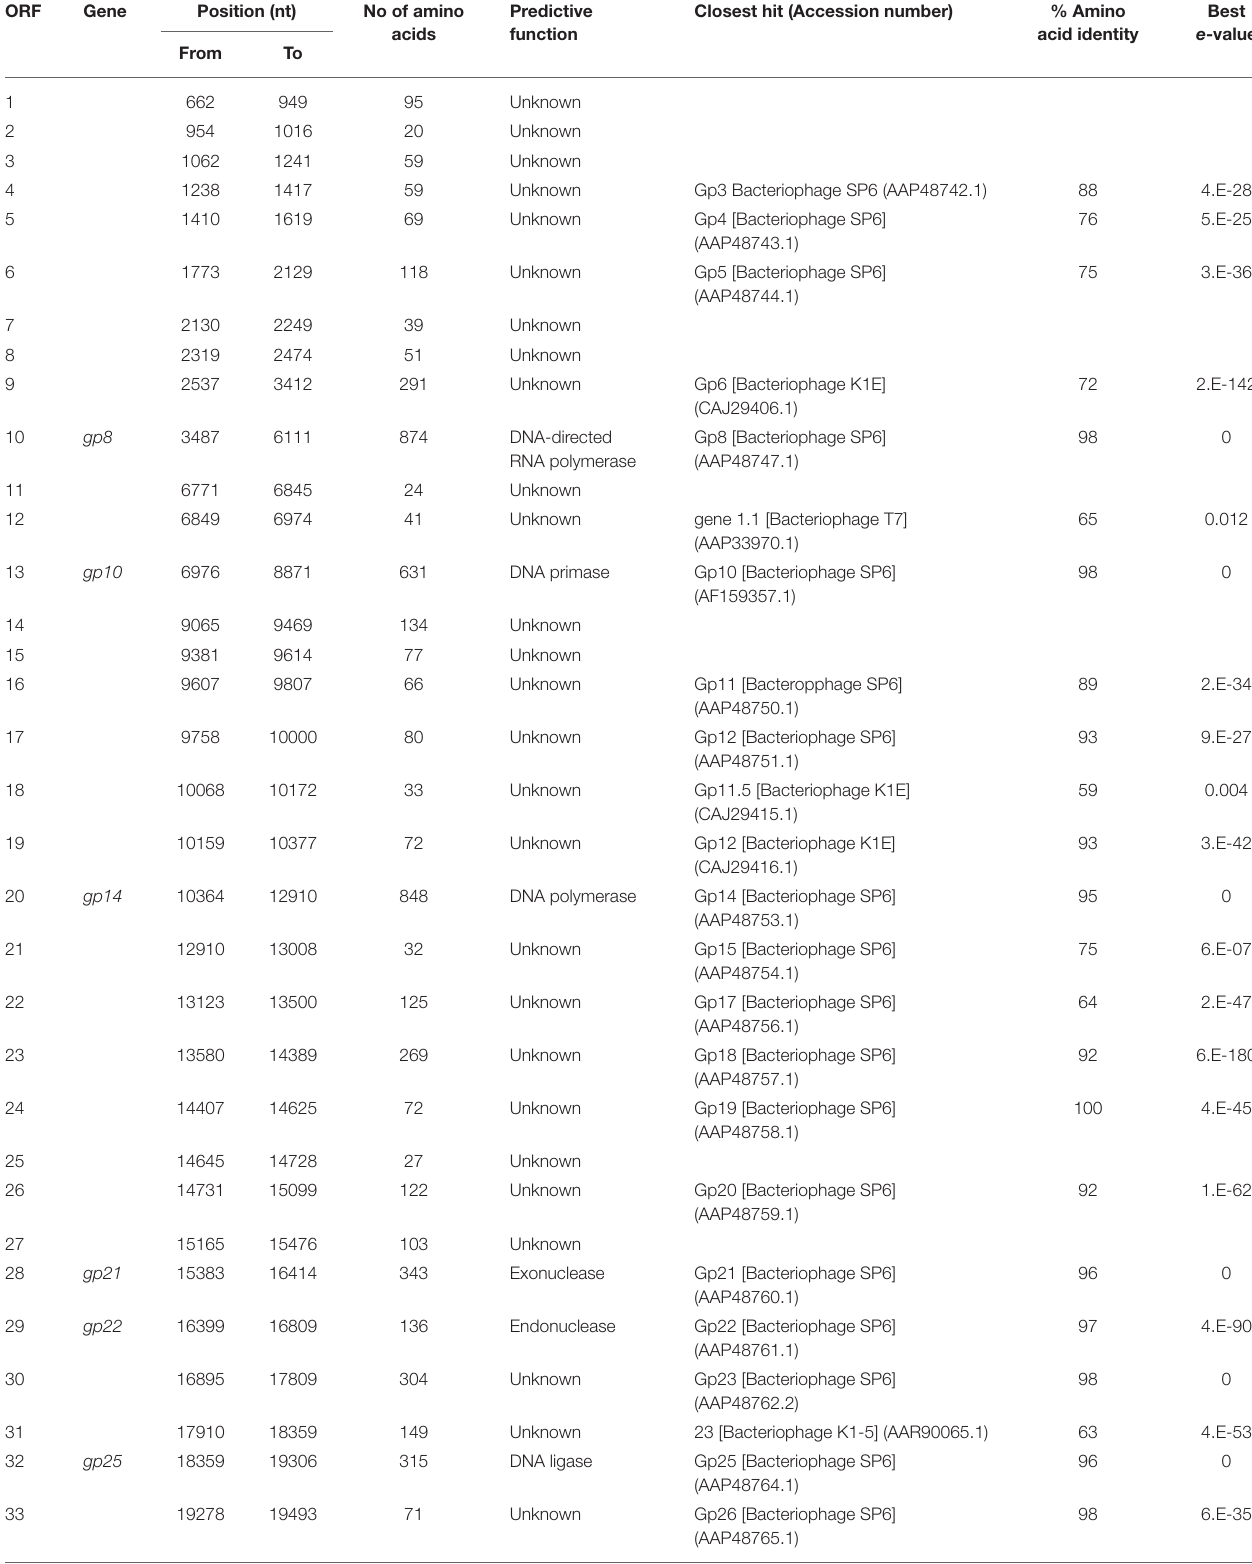
TABLE 2 | Features of bacteriophage UAB_Phi78 genome, ORFs, gene products, and functional assignments. ORF No of amino